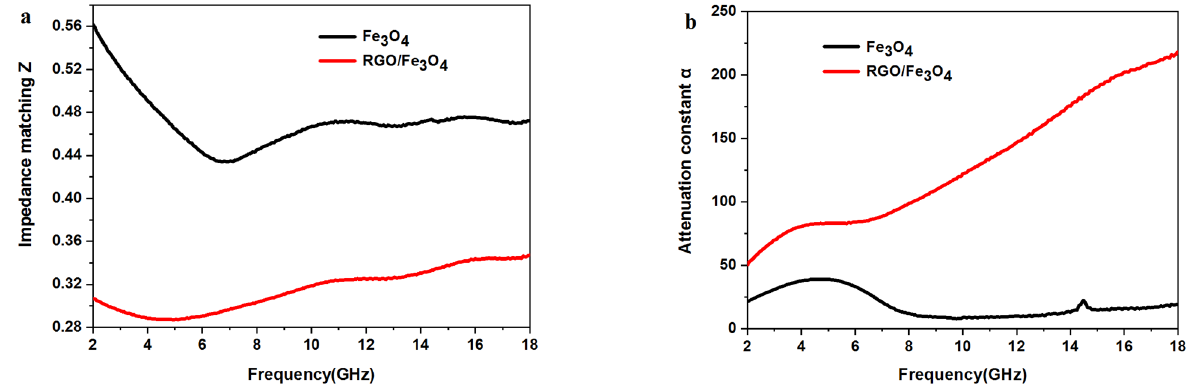
Figure 11. ( a ) Impedance matching ( Z ) and ( b ) attenuation constant ( α ) of the as-prepared RGO/Fe 3 O 4